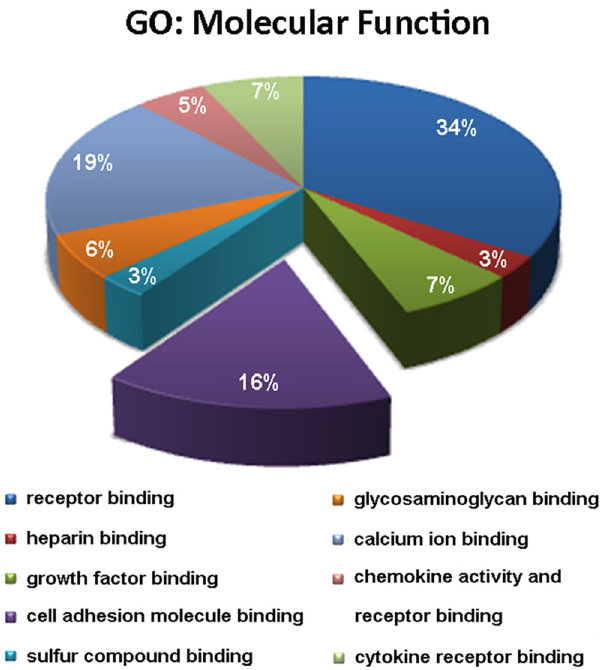
Fig 1. Functional enrichment representation showing that cell adhesion is the third most altered category in ICM pathology. ToppGene results in terms of Gene ontology (GO) were obtained based on Molecular Function and were corrected using Bonferroni method. The diagram includes the main categories in which differentially expressed genes are classified. ICM, ischemic cardiomyopathy.